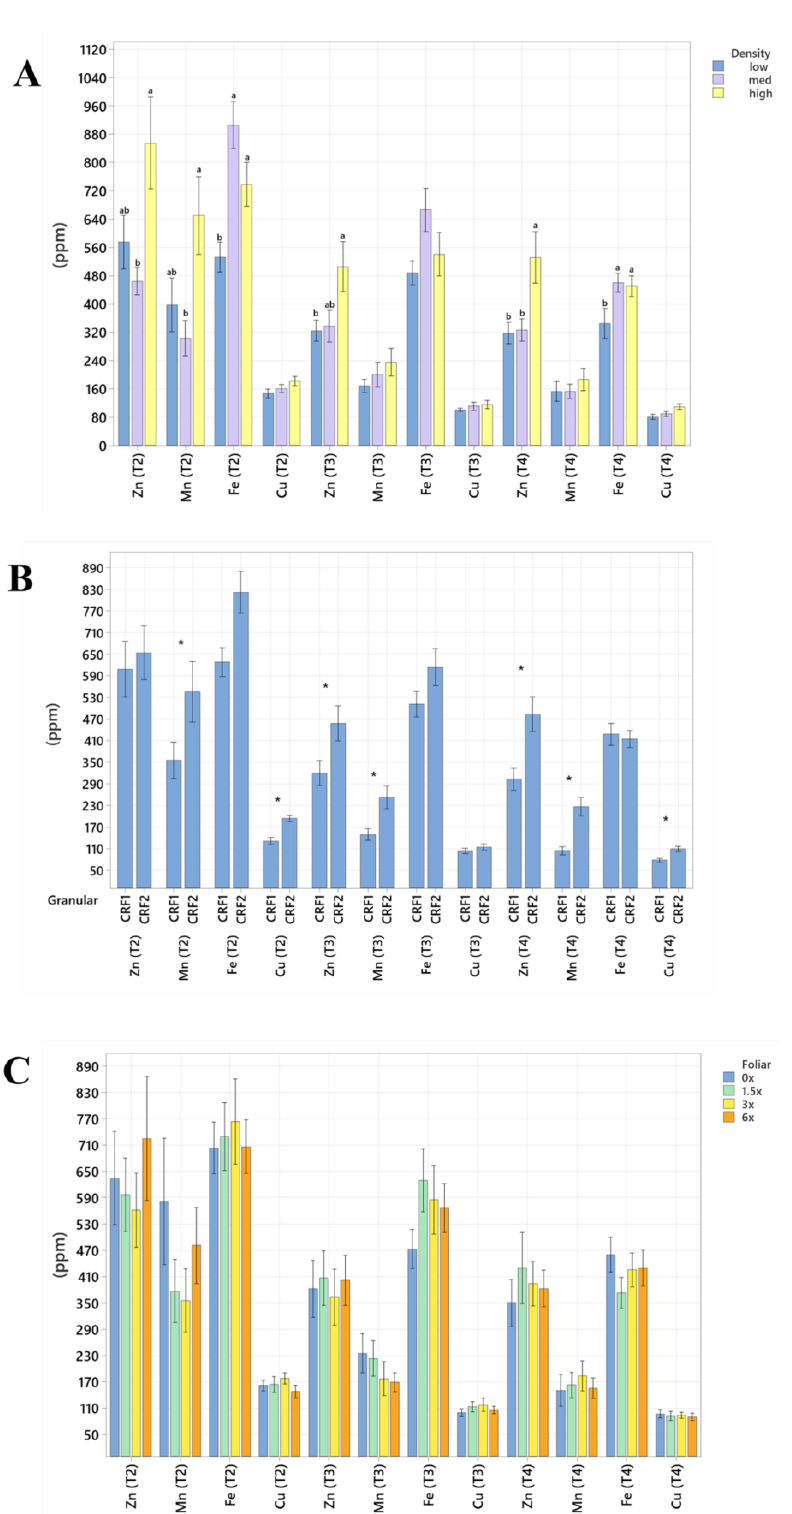
Figure 7. Root micronutrient concentrations of ‘Ray Ruby’ grapefruit grafted on ‘Kuharske’ citrange planted in flatwood soils located in Fort Pierce, FL, USA. Graphs indicate response to ( A ) planting density, ( B ) ground-applied fertilizer and ( C ) foliar fertilizer treatments during May 2021 (T2), September 2021 (T3) and January 2022 (T4). Bars are ± standard deviation of the mean, and treatments with * and different letters were considered to be significantly different ( p < 0.05).